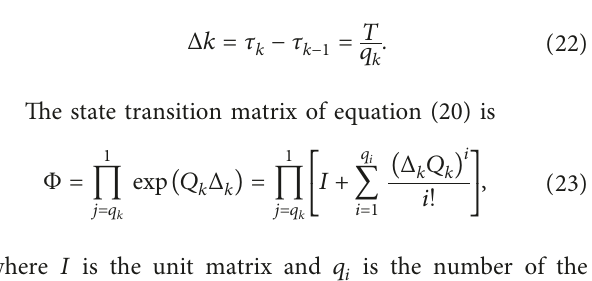
� 0.2, (b) F I � 2.0. I